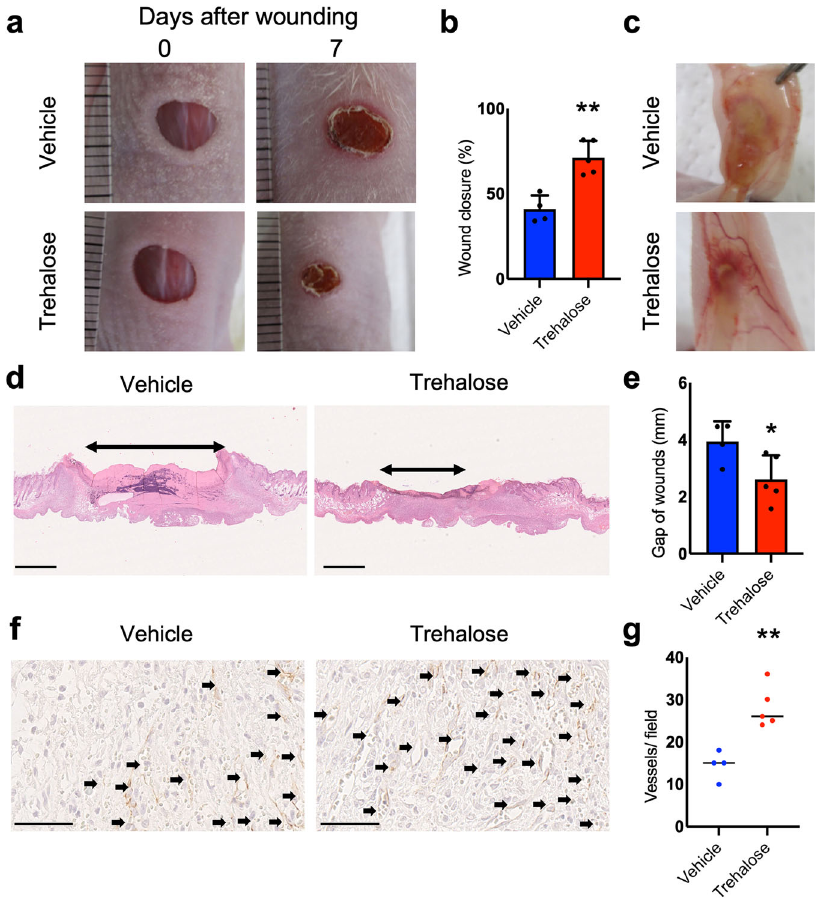
Fig. 8 Graft of dermal substitute with highly concentrated trehalose-treated fi broblasts on nude mice accelerates murine wound closure and angiogenesis. a Representative photographs of the wound area on the recipient nude mice as indicated at 7 days after transplantation. b Wound closure was quanti fi ed and presented as % wound closure; % = the percentage of the initial wound area size at day 7 when comparing the trehalose-LSE group (red band) to the control group (blue band). c Representative photographs of angiogenesis induced by the grafts. d Images of the H&E-stained tissue sections from the wound sites on day 7. Bars = 1 mm. e Quantitative analysis of the gap of the wounds in comparison between the trehalose-LSE group (red band) and control group (blue band). f Images of CD31 immunostaining on the day 7 wounds. Bars = 50 μ m. g Quantitative analysis of CD31-positive vessels per fi eld. Data were expressed as means ± SD. A subsequent statistical analysis was performed with the Student t -test. * P < 0.05 and ** P < 0.01, with four mice in the control group, fi ve in the trehalose-LSE group, and one tissue section from each mouse. Data were representative of three independent